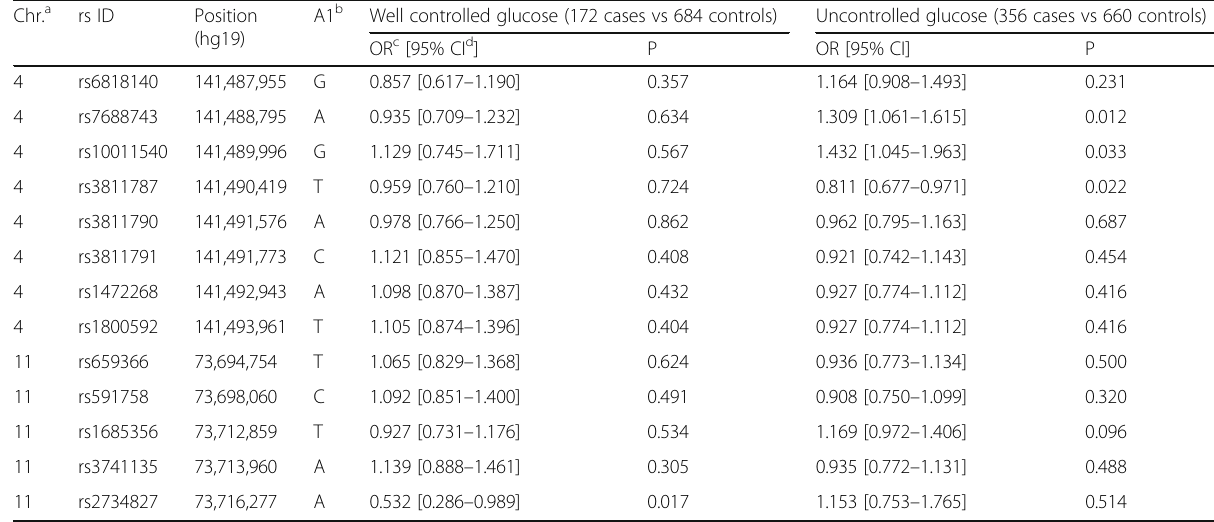
Table 5 The association between uncoupling proteins and diabetic retinopathy in participants with and without controlled glucose Chr. a rs ID Position A1 b Well controlled glucose (172 cases vs 684 controls) Uncontrolled glucose (356 cases vs 660 controls) (hg19)